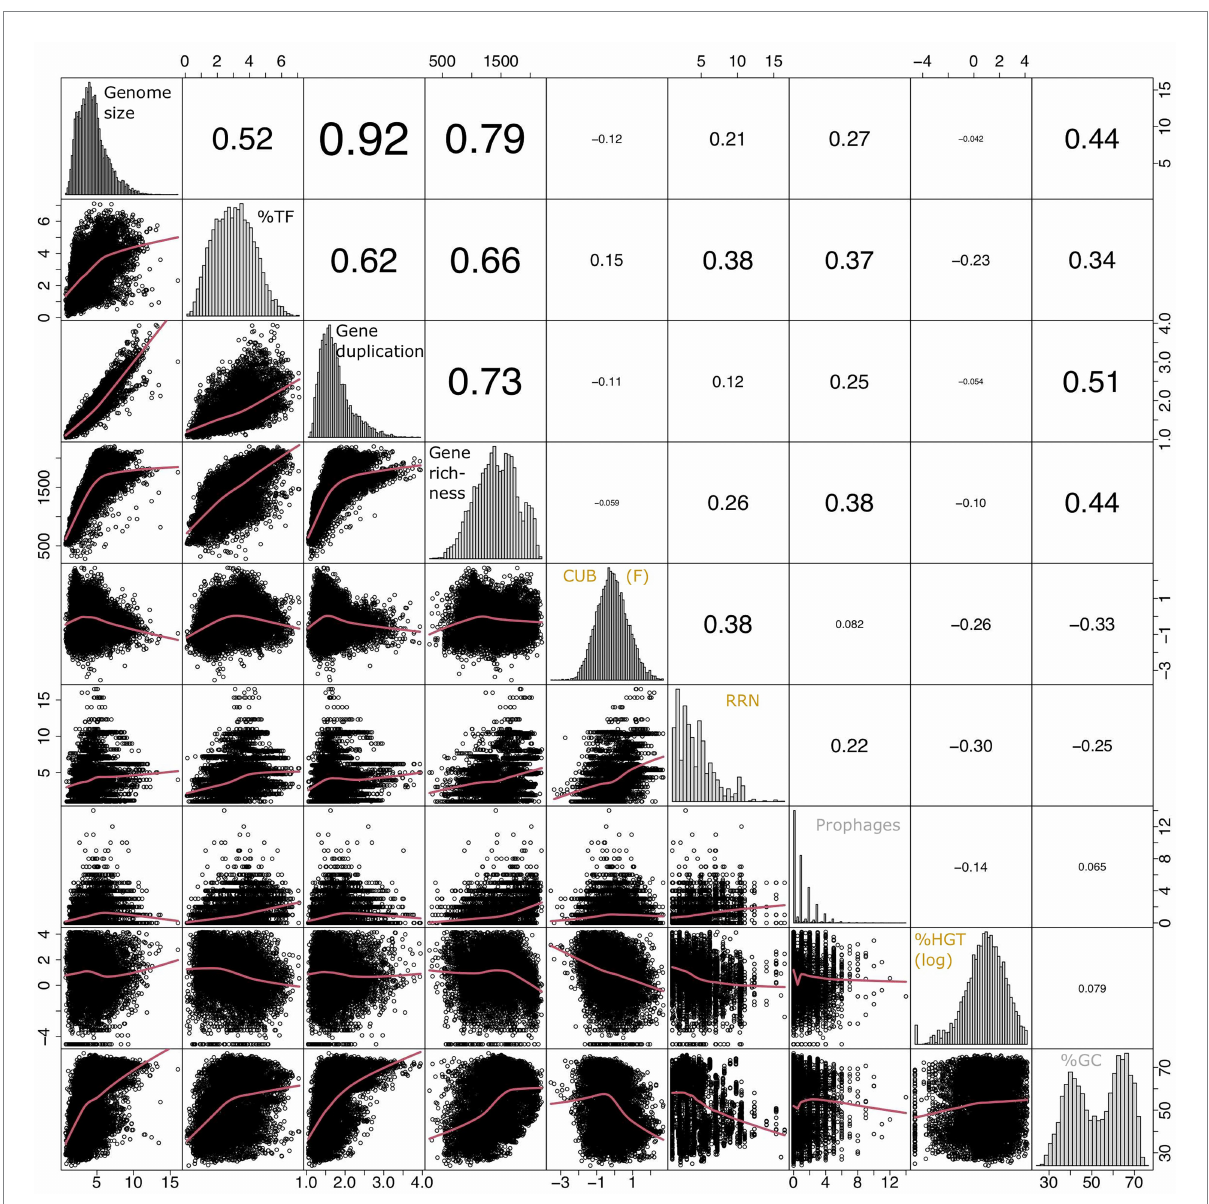
FIGURE 4 Overview of pairwise correlation patterns among genomic traits from 8,847 species delineated from sequenced prokaryotic genomes available via the JGI/IMG platform (https://img.jgi.doe.gov/) and created via the R command chart.Correlation in the R package PerformanceAnalytics (v2.0.4). The lower panels illustrate pairwise correlation plots fit via loess smoothing statistics with the smoothing parameter f set to 2/3 and the number of robustness iterations set to 3. The value in the upper panels indicate strength of the pairwise correlations (rho, Spearman rank correlation). The diagonal panels illustrate the distribution of the input variables. The CUB was estimated via the variable F as detailed elsewhere (Vieira-Silva and Rocha, 2010). The value for %HGT was log(x + 0.001) transformed to approximate normal distribution. The variables RRN and prophages were not transformed as no transformation option improved the fit to normal distribution. The raw values of all data are given in Supplementary Table